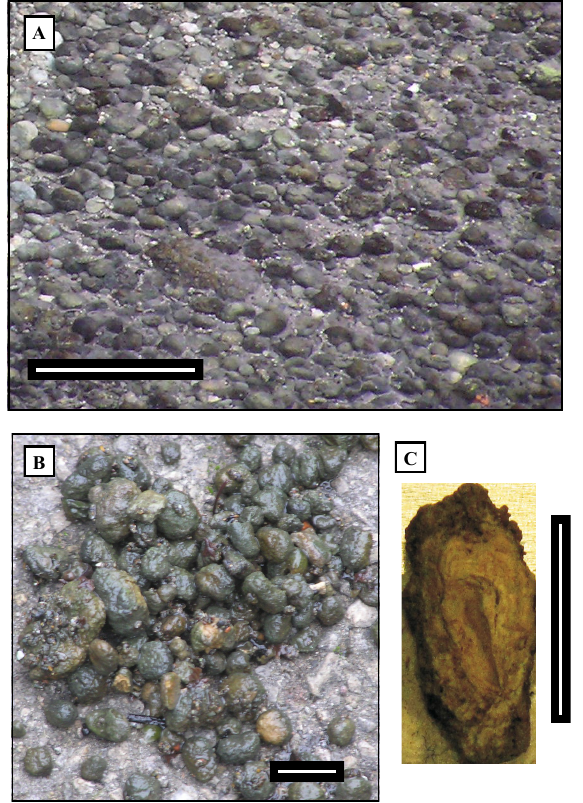
Figure 9. Marginally precipitating systems under low tempera- ture. (A) Sub-tufa oncoids in a flowing, shallow stream without any framework tufa associations. These typically build climbing ripple bedforms. Scale bar is 150mm long. Welton Beck, Yorkshire, UK. (B) Close up of a random sample of living oncoids showing charac- teristic greyish green colour. Note the virtual absence of any detrital tufa or cements between the oncoids. Scale bar is 15mm long. Wel- ton Beck, Yorkshire, UK. (C) Oncoid in cross section from River Bradford, Derbyshire, UK. Note colonised surface (left and top) is not continuous, and laminae are apparent (e.g. light coloured middle section) but these are discontinuous on the scale of a few millime- tres. Dark core material (centre) is a flake-shaped piece of carbonif- erous limestone. Scale bar is 50mm